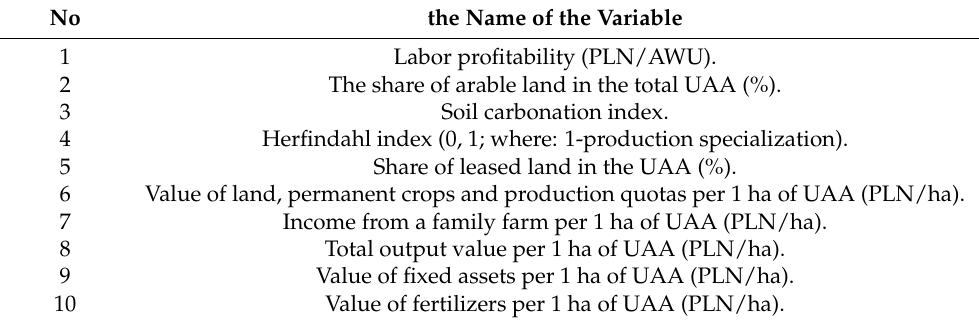
Table 3. Diagnostic variables accepted for the